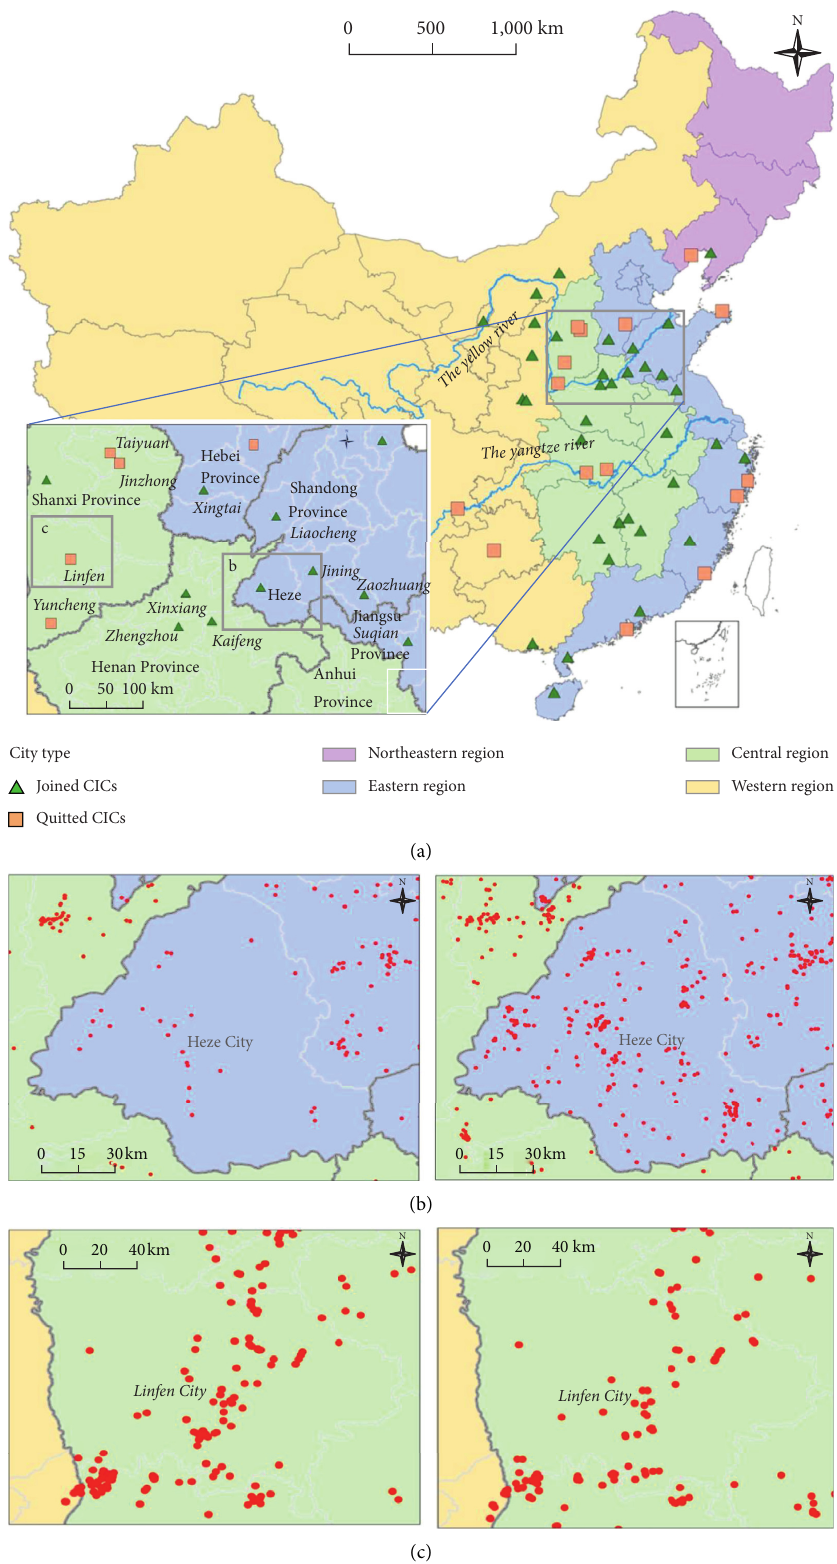
Figure 5: Changes in China’s chemical industrial cities (CICs) and firms, 2003–2013. (a) Distribution of CICs that joined and quitted in China and a magnified view of middle and lower reaches of the Yellow River. (b) Firm distribution in 2003 and 2013 in Heze City, respectively. (c) Firm distribution in 2003 and 2013 in Linfen City,